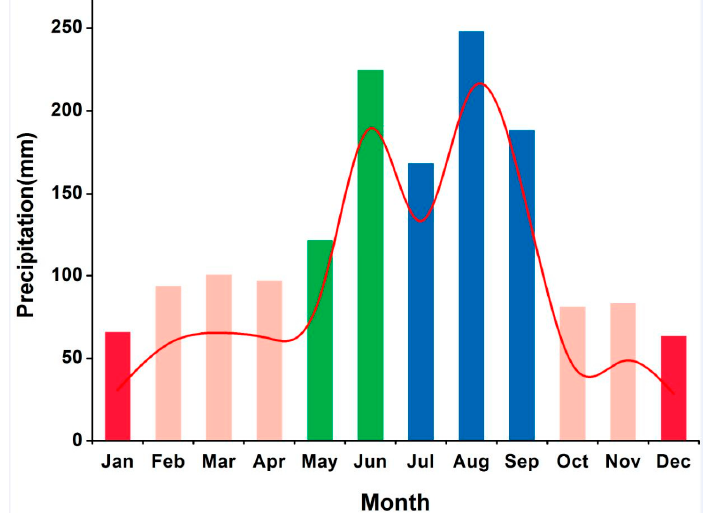
Figure 2. The 2001–2015 monthly mean precipitation in the Xian-Jiang Basin.